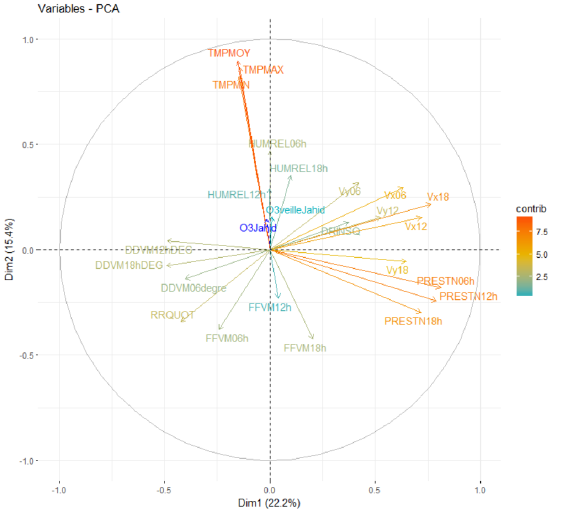
Figure 3. Correlation circle variables (1 − 2) factorial plane) according to the contributions of variables to PCs: O3Jahid (dashed blue) considered as a supplementary